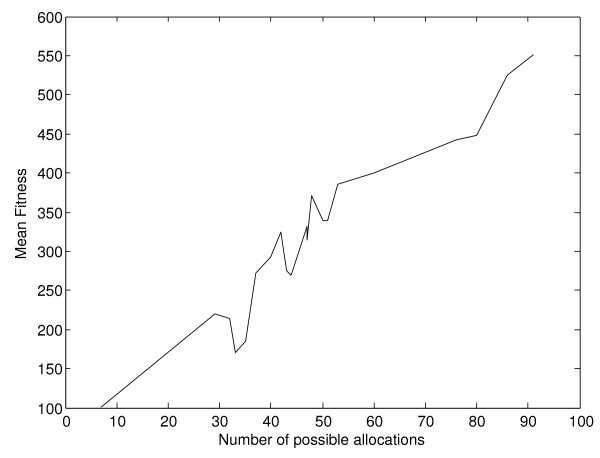
Mean fitness per experiment for module search algorithm, according to search space. As the size of the search space grows, following the number of possible genes to pathways allocations, the mean fitness reached by the algorithm follows suit.